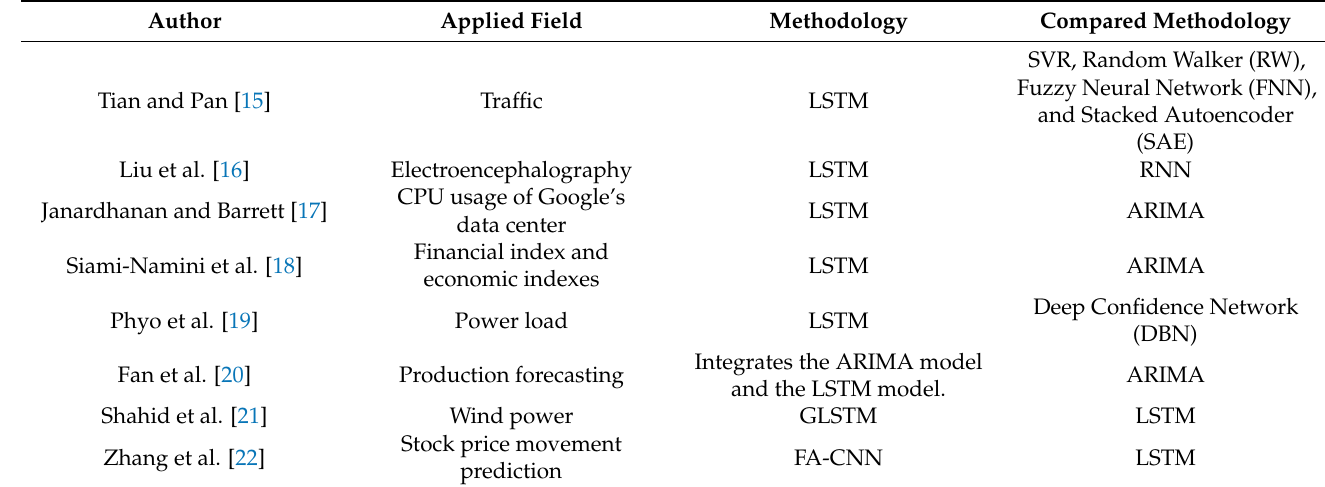
Table 1. Long short-term memory (LSTM) applications from